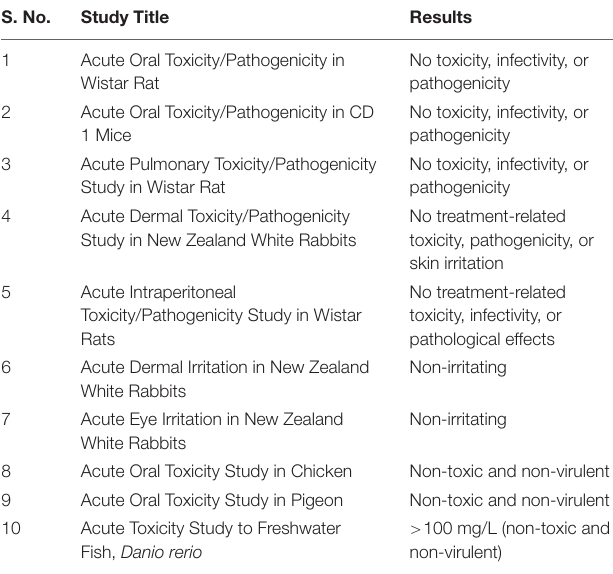
TABLE 4 | Toxicity of TrichoBARC formulation on mammals, birds, and fish. S.